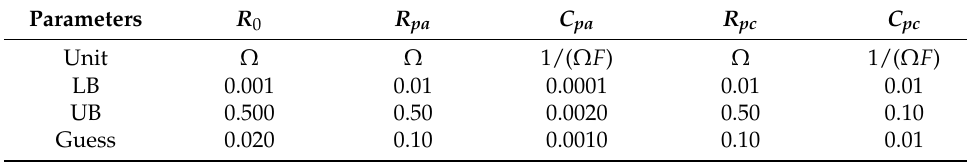
Table 1. NLLS Boundaries and initial guess.